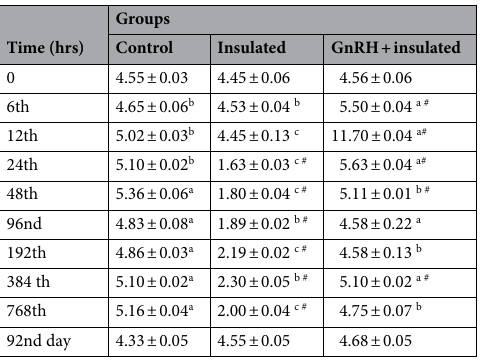
Table 7. Interaction between the insulation (with and without GnRH injection) and time on the serum concentrations of the testosterone in bucks. a,b,c Means with different small superscript letters in the same row are significantly different ( p < 0.05) (Duncan test). # Significant different as compared to zero time in the same group (Paired T- test).